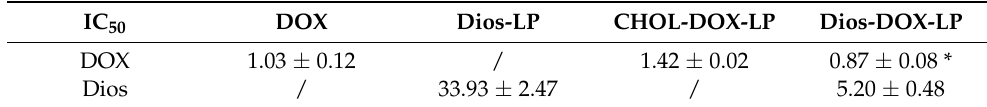
Figure 5. The synergistic effect of DOX and Dios on HepG2 cells. ( A ) The cell viability of different proportions of DOX + Dios on HepG2 cells; ( B ) CI values of DOX + Dios in different proportions. Table 3. IC 50 of DOX, Dios-LP, CHOL-DOX-LP and Dios-DOX-LP ( μ M). Table 3. IC 50 of DOX, Dios-LP, CHOL-DOX-LP and Dios-DOX-LP ( µ M).